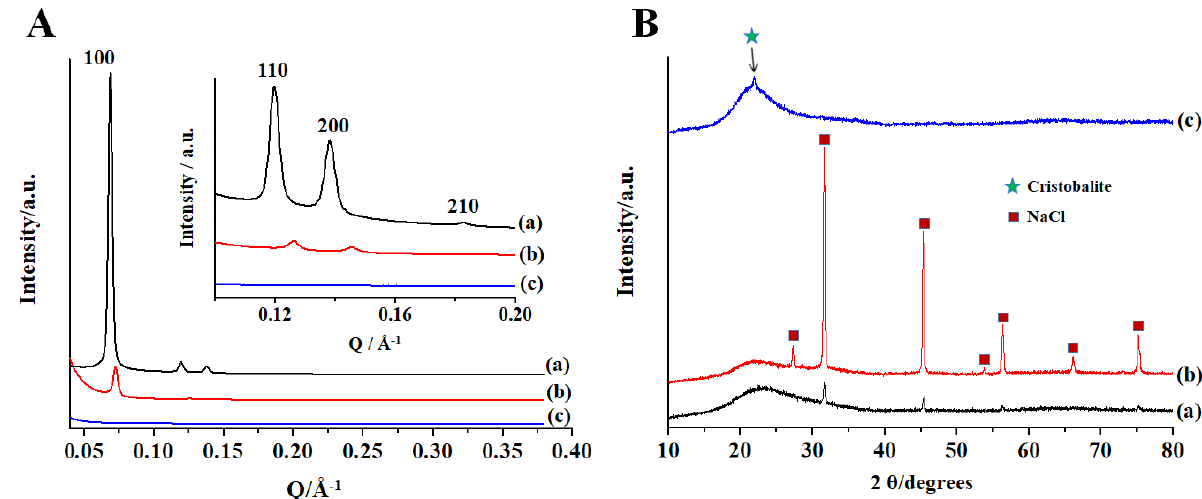
Figure 2. SAXS ( A ) and XRD ( B ) patterns of (a) SBA15-Na-40-500, (b) SBA15-Na-40-600 and (c) SBA15-Na-40-650 after thermal treatment with different temperatures (500 – 650 °C) using Si/Na = 40. Inset in Figure 2A shows the magnified SAXS patterns in the range of q = 0.10 – 0.20 for samples.